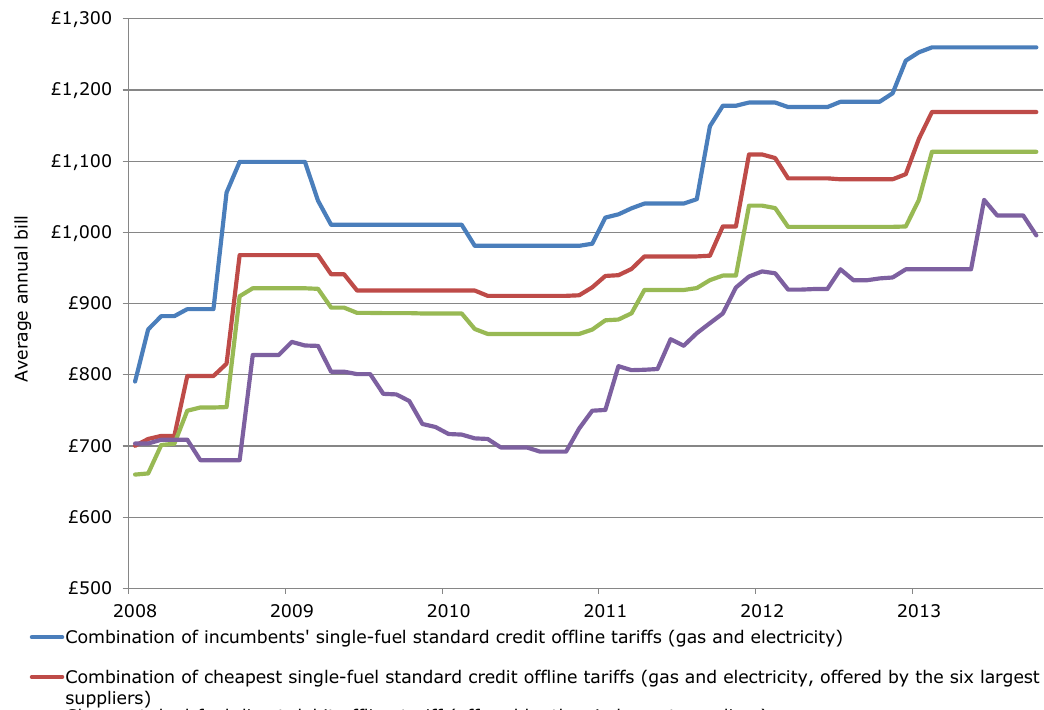
Figure 17: Comparison of the prices of a selection of single-fuel and dual- fuel